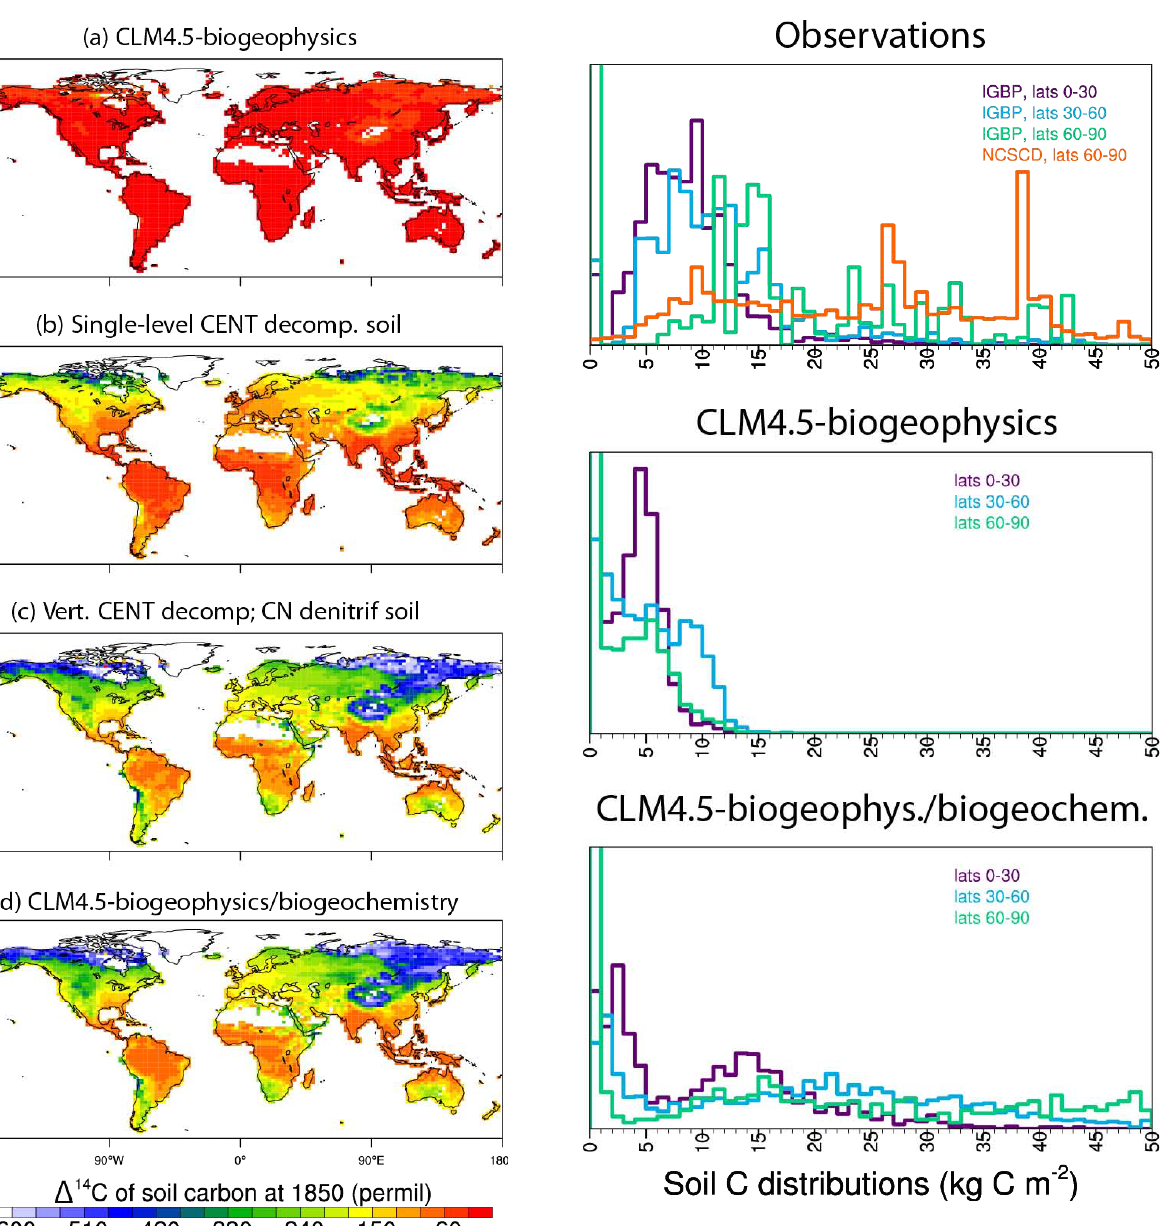
Fig. 7. Histograms of Soil C to 1m for various model cases and for